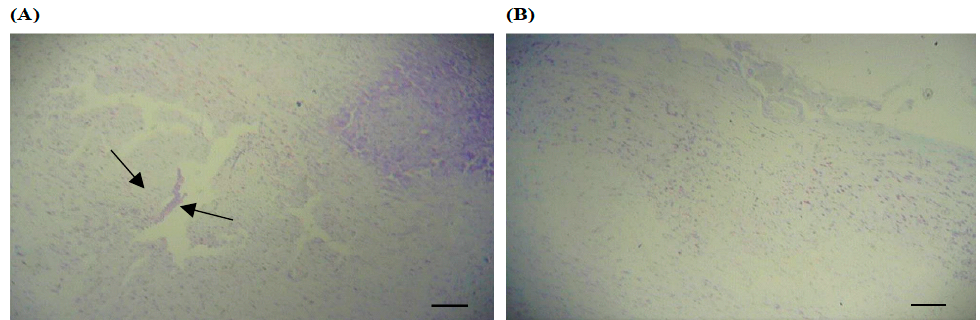
Figure 2. Photomicrograph of the Substantia nigra of the midbrain at 4 × magnification. ( A ) Animal from the PD group. ( B ) Animal from the Sham Group. The arrows show the area of electrolyte damage in the substantia nigra of animals with PD.